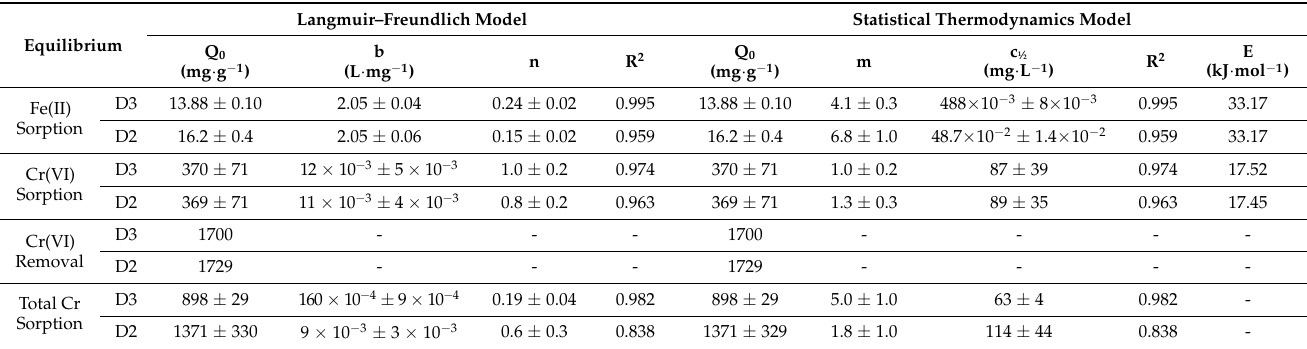
Table 3. Parameters obtained from the isotherm models for Fe(II) sorption, Cr(VI) sorption, and total chromium sorption. The Q 0 value for Cr(VI) removal was obtained directly from the experimental data without using any isotherm